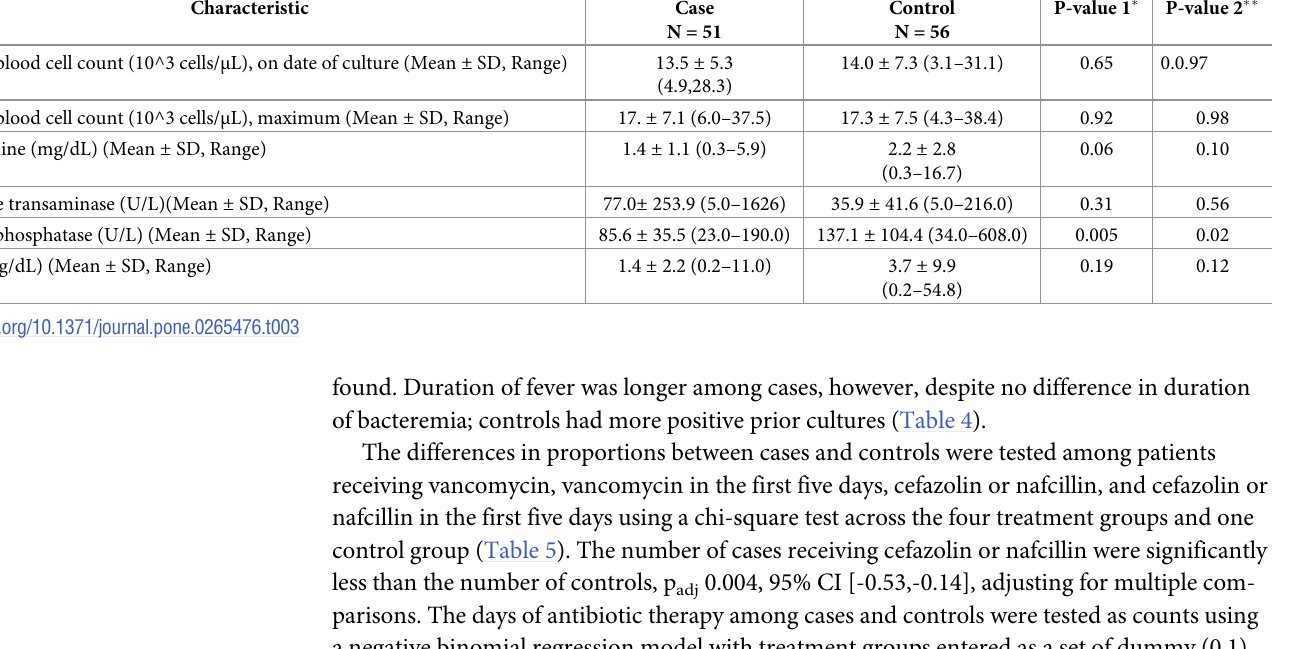
parisons. The days of antibiotic therapy among cases and controls were tested as counts using a negative binomial regression model with treatment groups entered as a set of dummy (0,1) variables with the control group as the reference. No statistical difference in days of therapy was found (all p-values > 0.05).